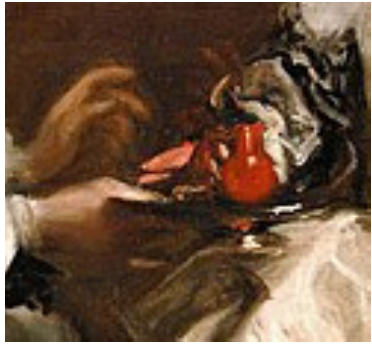
Figure 5. Detail , búcaro (Velázquez 1656). Figure 5. Detail, b ú caro (Vel á zquez